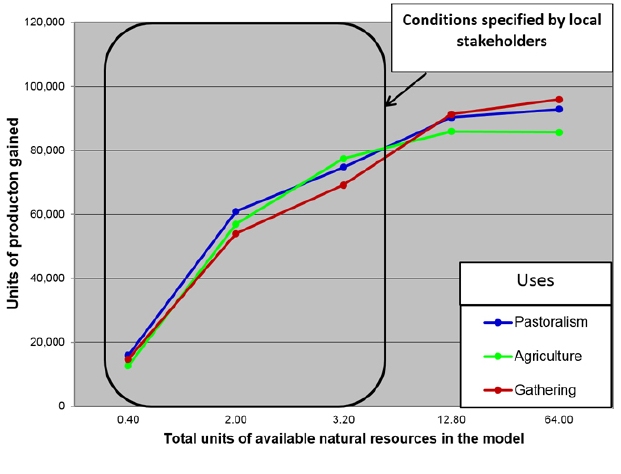
Fig. 8 . Productivity of the three major uses according to the level of resource scarcity, including the impact of rainfall. The x and y axes are the same as in the previous graph,